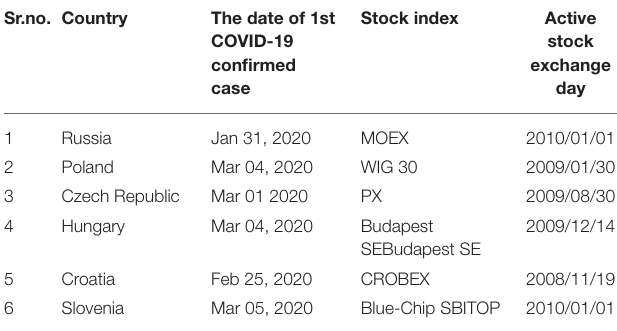
TABLE 1 | The information for our sample countries in Eastern Europe. Sr.no.